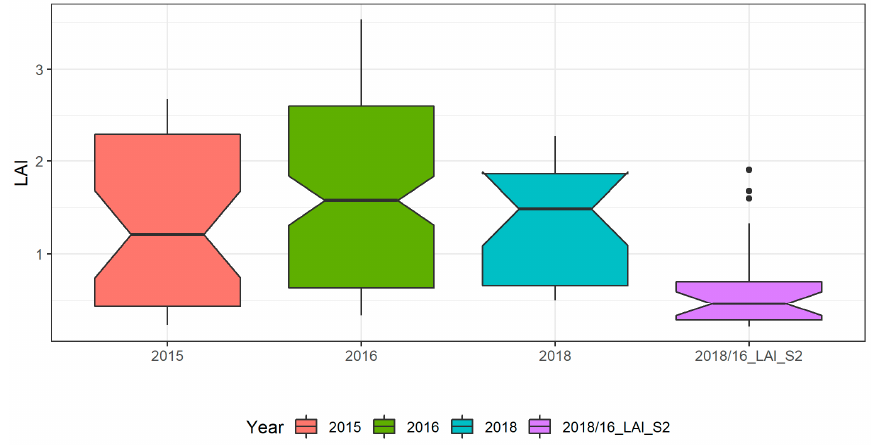
Figure 5. Boxplot of the field LAI for the three years: 2015 (n = 40), 2016 (n = 137), 2018 (n = 23), and derived from sentinel products, 2016/18_LAI_S2 (n = 22).